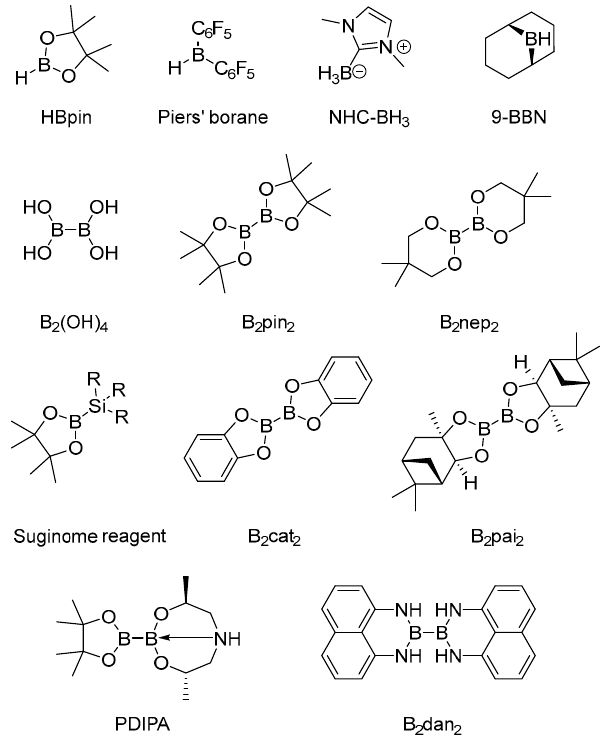
Figure 1. Commonly used boron reagents involved in Cu-boryl promoted reactions. The organic synthesis promoted by copper-boryl intermediates has attracted enthusi- asm for developing various reactions including hydroboration, carboboration, diboration, and heteroboration with unsaturated substrates of C=C/C ≡ C/C=E multiple bonds (Figure 2) [14–16]. For most of the borylation reactions, the copper alkoxide species is formed in situ by the reaction of copper(I) salt and an alkoxide base [17]. After that, it will react with a diboron reagent to produce the copper-boryl complexes. Finally, the electrophile partici- pates in the reaction. Thus, the ligand exchanges with the alkoxide base and regenerates the copper alkoxide species. The general mechanism is given in Scheme 1 [18].